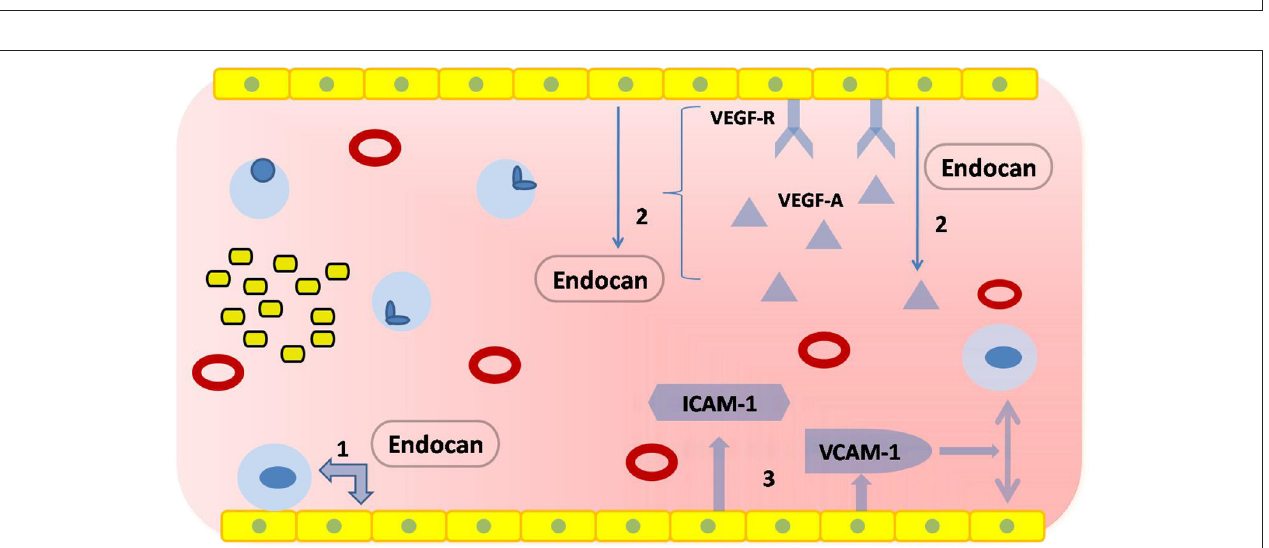
FIGURE 3 | Graphic abstract of this review.